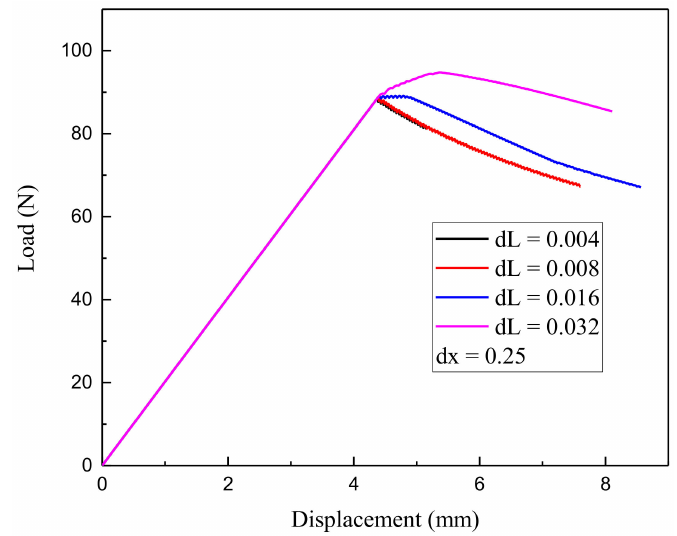
Figure 9. Convergence analysis of loading increment dL for grid spacing dx = 0.25 mm, PD modeling load–displacement.